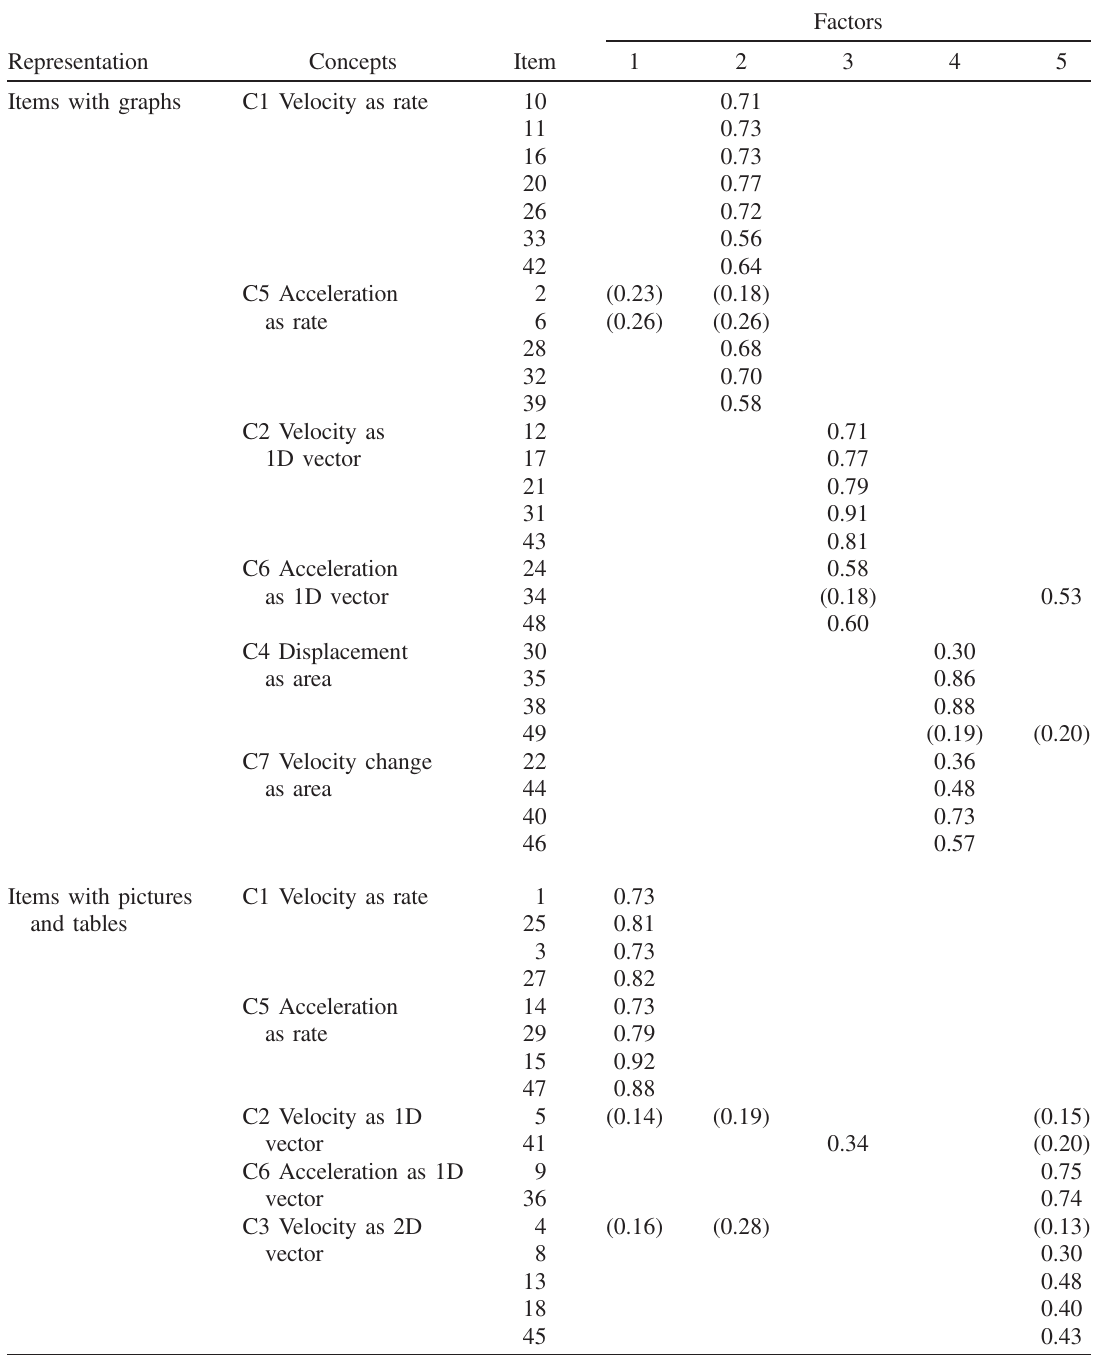
TABLE VII. Pattern matrix for the five-factor model gained from PAF analysis with promax rotation. All 45 items are included in the analysis. Values below 0.20 are shown only in the absence of significant values ( ≥ 0 . 30